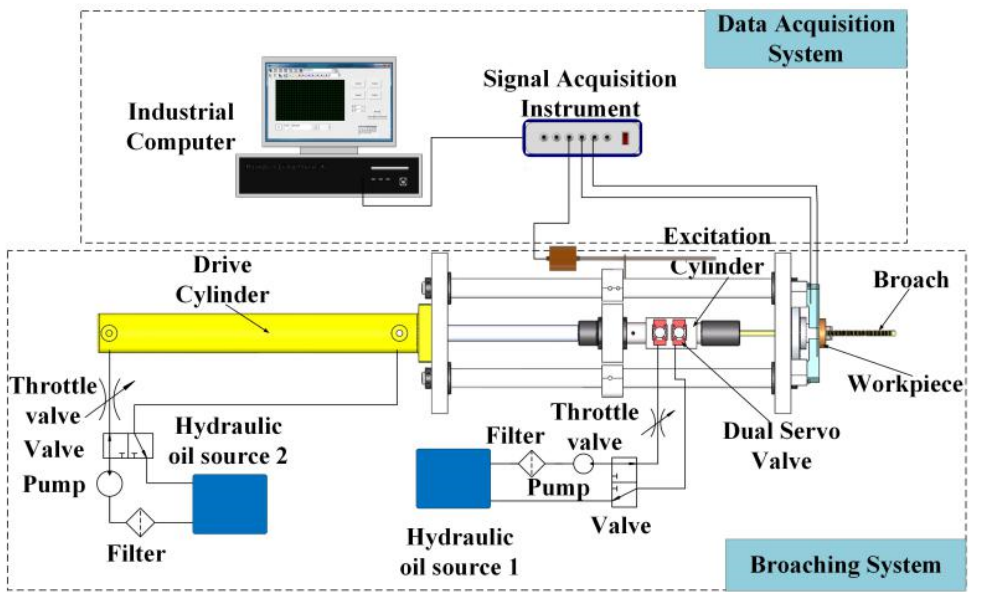
Figure 2. Schematic illustration of the HVAB test setup.